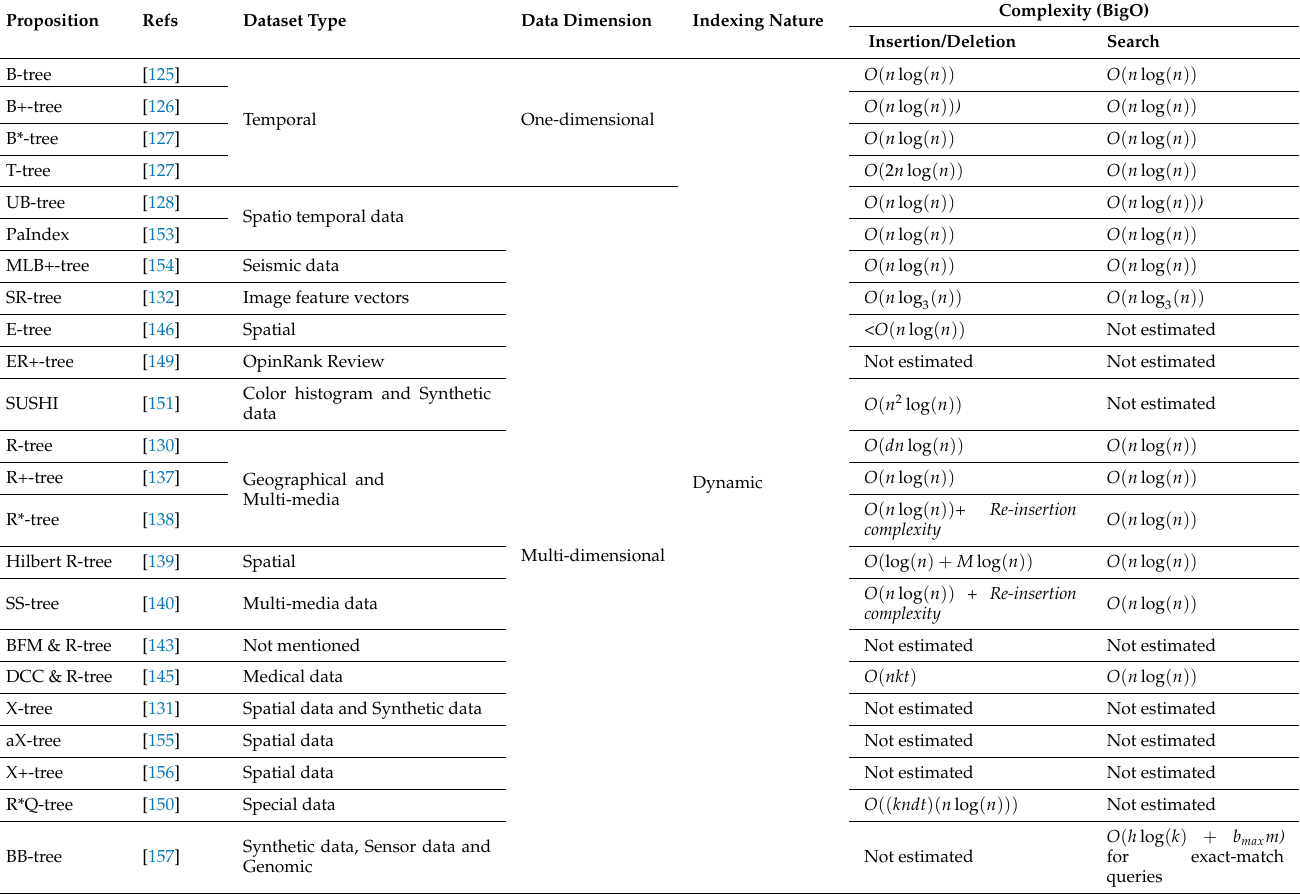
Table 7. Analysis of multidimensional indexing techniques based on data